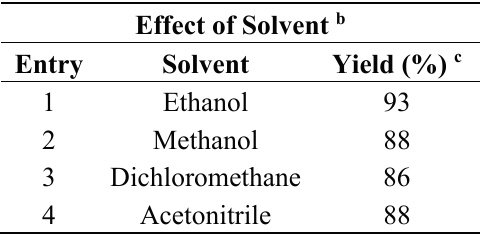
Table 3. Effect of solvent on the yield of tetraaryl imidazole 8 at 10 mol % catalyst.